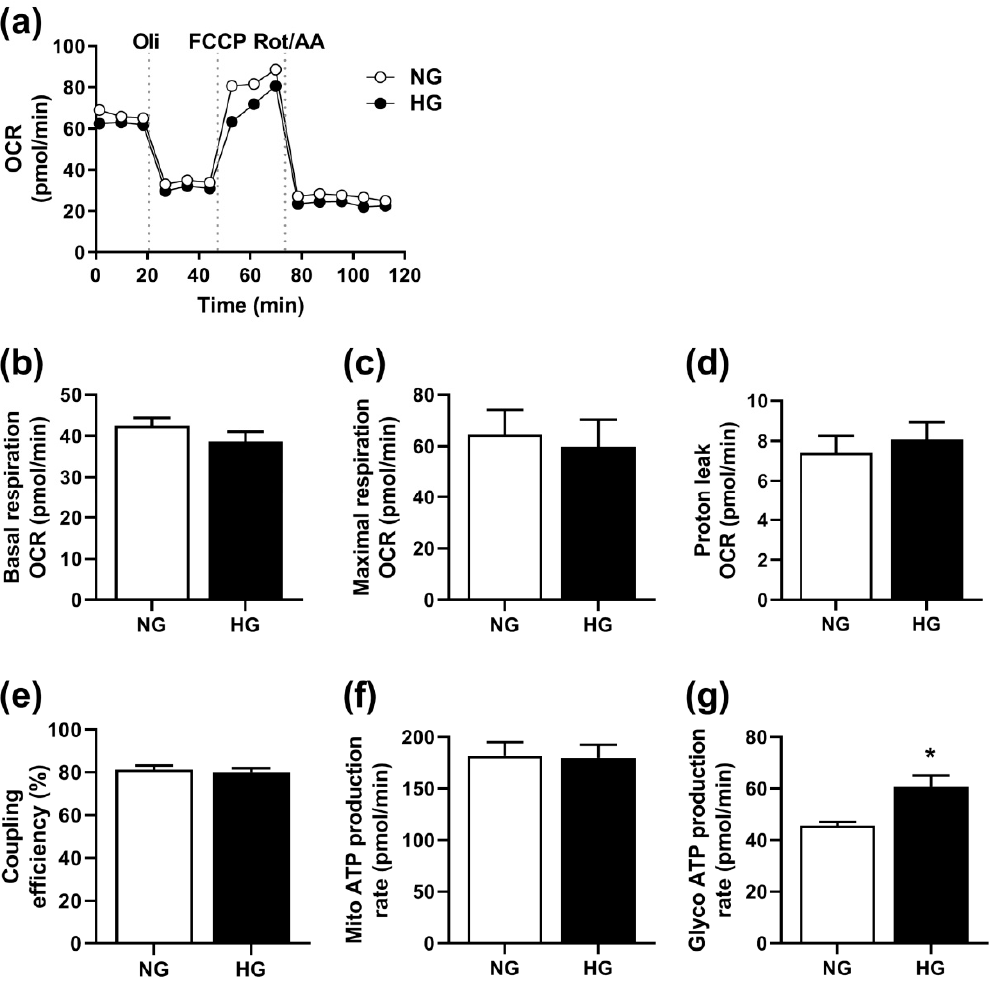
Figure 2. Effects of chronic hyperglycemia on mitochondrial function. Human skeletal muscle cells were grown in 24-well Seahorse tissue culture plates, exposed to 20 mM glucose (HG) for the last four days of the differentiation period, or standard differentiation medium (NG, 5.5 mM glucose), before measurement of the oxygen consumption rate (OCR) with the Seahorse XF24e analyzer. OCR was recorded three times at 6 min intervals at baseline, and following injections with 5 µM oligomycin (Oli), 3 µM FCCP and 4 µM rotenone/antimycin A (Rot/AA), respectively (XF Cell Mito Stress Test Kit). Determinants of mitochondrial function were calculated as described in Section 2.5. ( a ) One representative experiment. ( b – g ) Mean ± SEM from five individual experiments (n = 5). ( b ): basal respiration calculated from OCR in pmol/min, ( c ): maximal respiration calculated from OCR in pmol/min, ( d ): proton leak calculated from OCR in pmol/min, ( e ): percentage coupling efficiency, ( f ): mitochondrial (Mito) ATP production rate in pmol/min, and ( g ): glycolytic (Glyco) ATP production rate in pmol/min. *Statistically significant vs. NG ( p < 0.05, unpaired Student’s t -test).